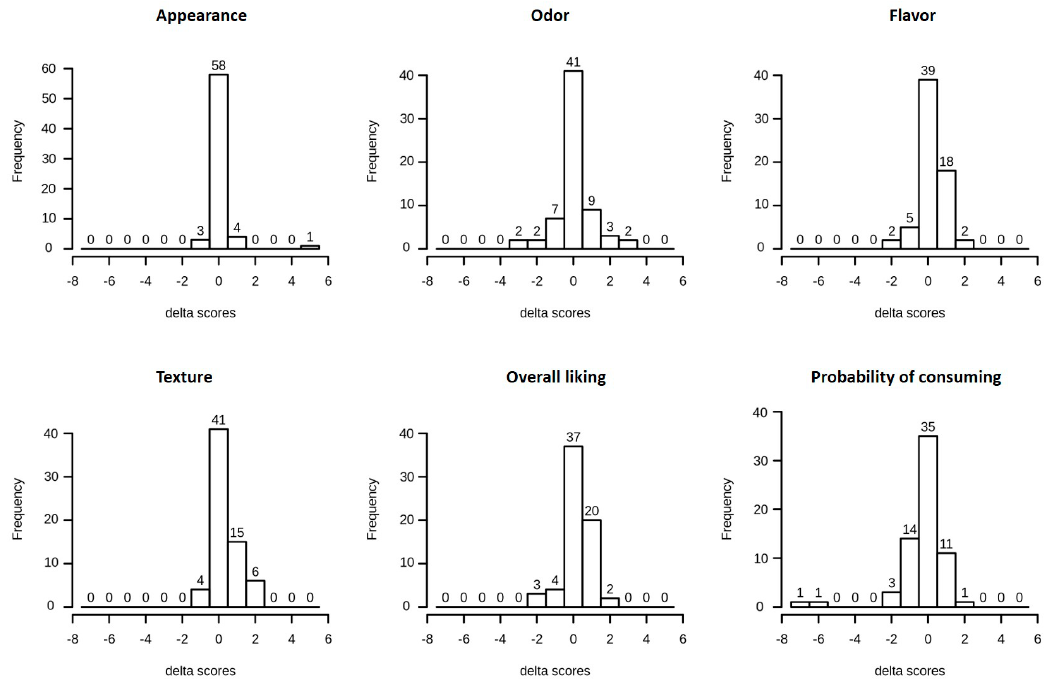
Figure 3. Delta scores between “insect labelled” sample and “control” bread.